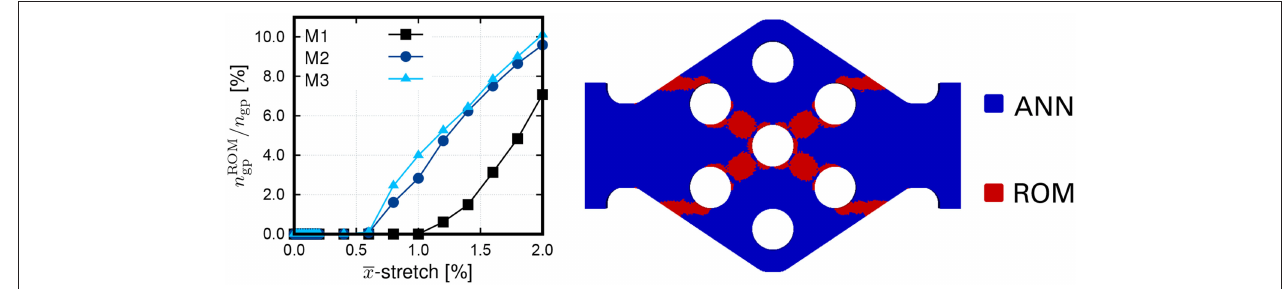
FIGURE 9 | (Left) Relative amount of integration points with active ROM during the adaptive twoscale simulation; (Right) Quality indicator χ K at the end of the adaptive twoscale simulation using mesh M3.